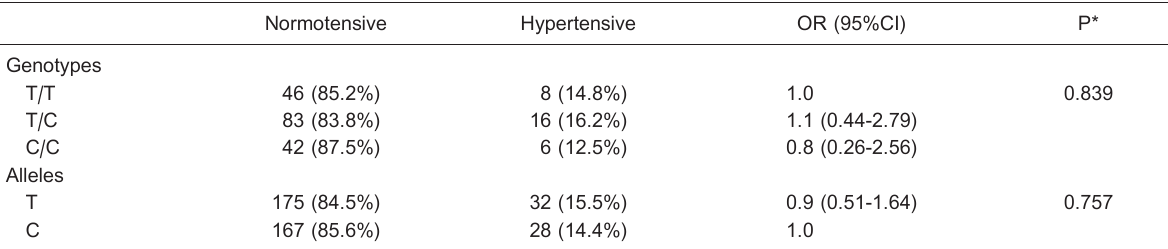
Table 2. Analysis of the association between the M235T polymorphism of the AGT gene and hypertension.